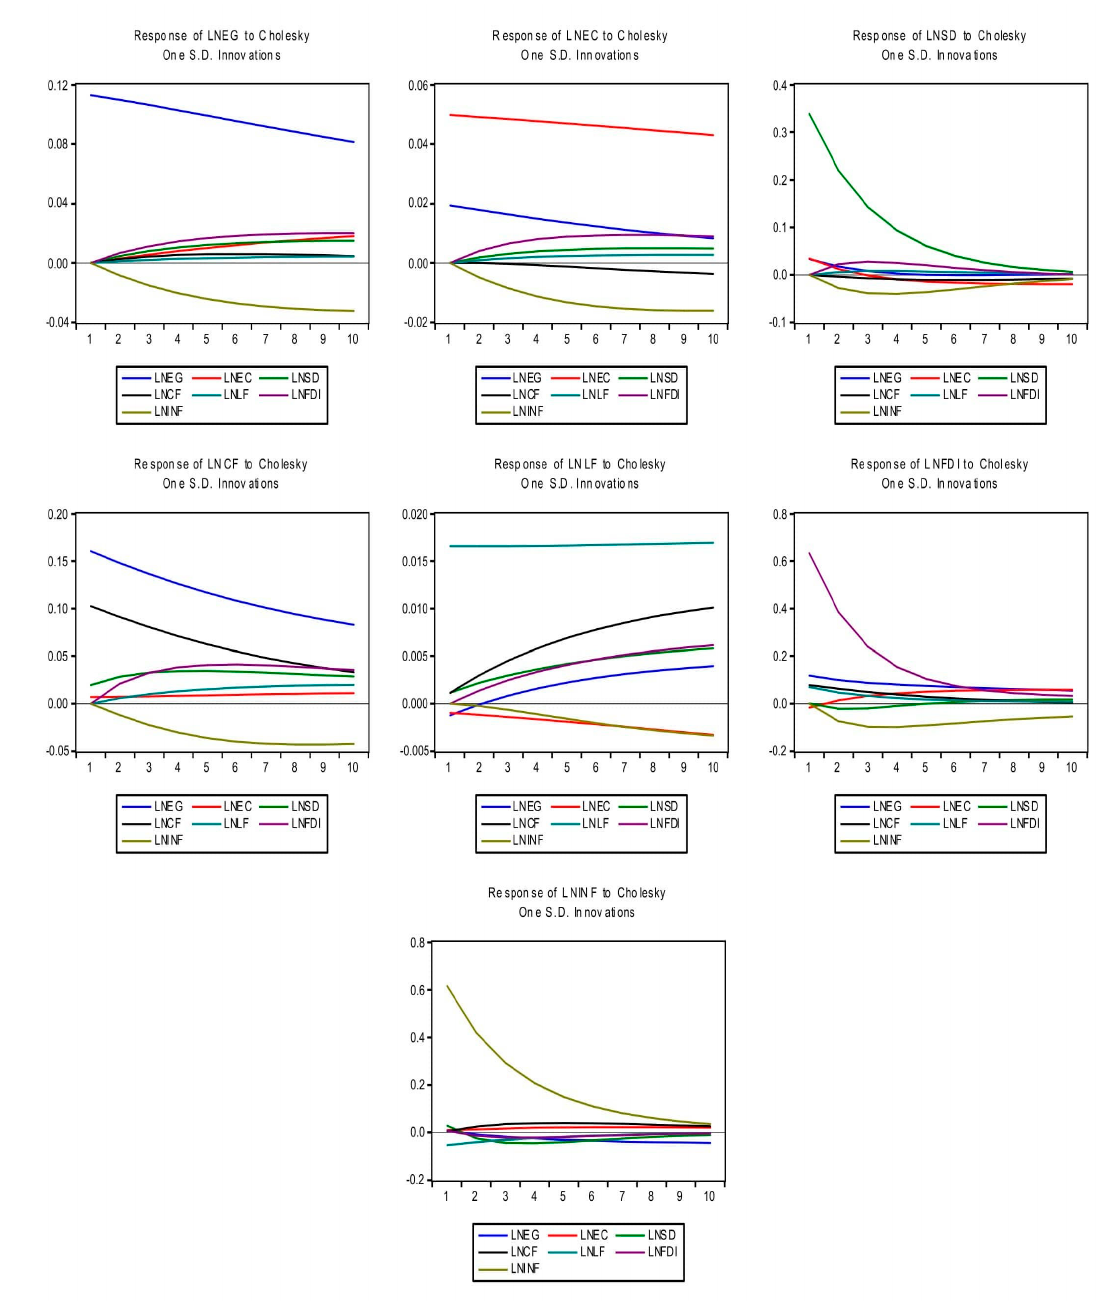
Figure 2. Impulse Response Analysis (IRA).